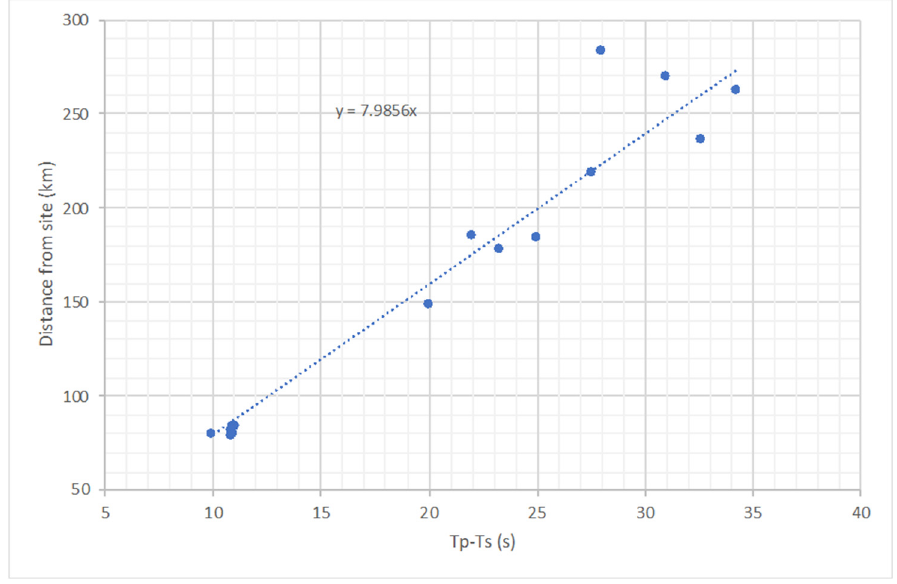
Figure 3. Distance to event epicentre versus the difference between P and S wave arrival times. Out of all 174 events, 119 had identifiable P and S waves. Using data from multiple wells corresponding to the same vertical depth, it is possible to search for azimuth and apparent horizontal velocity, which would minimise the misfit between the observed and theoretical arrival times for the P waves. This implies that the wave is a locally plane wave, and the velocity in the vicinity of the site is laterally uniform.